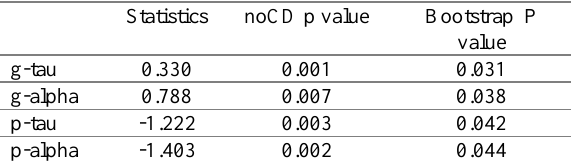
Table 11. Cointegration test results of Model 2